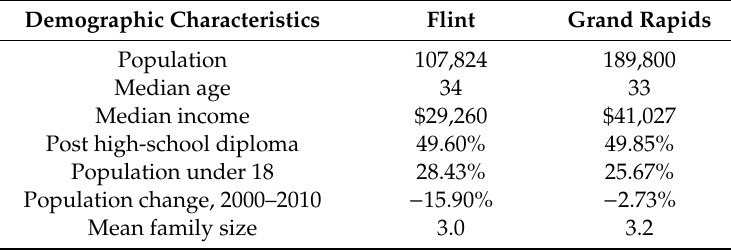
Table 1. Demographic and socioeconomic